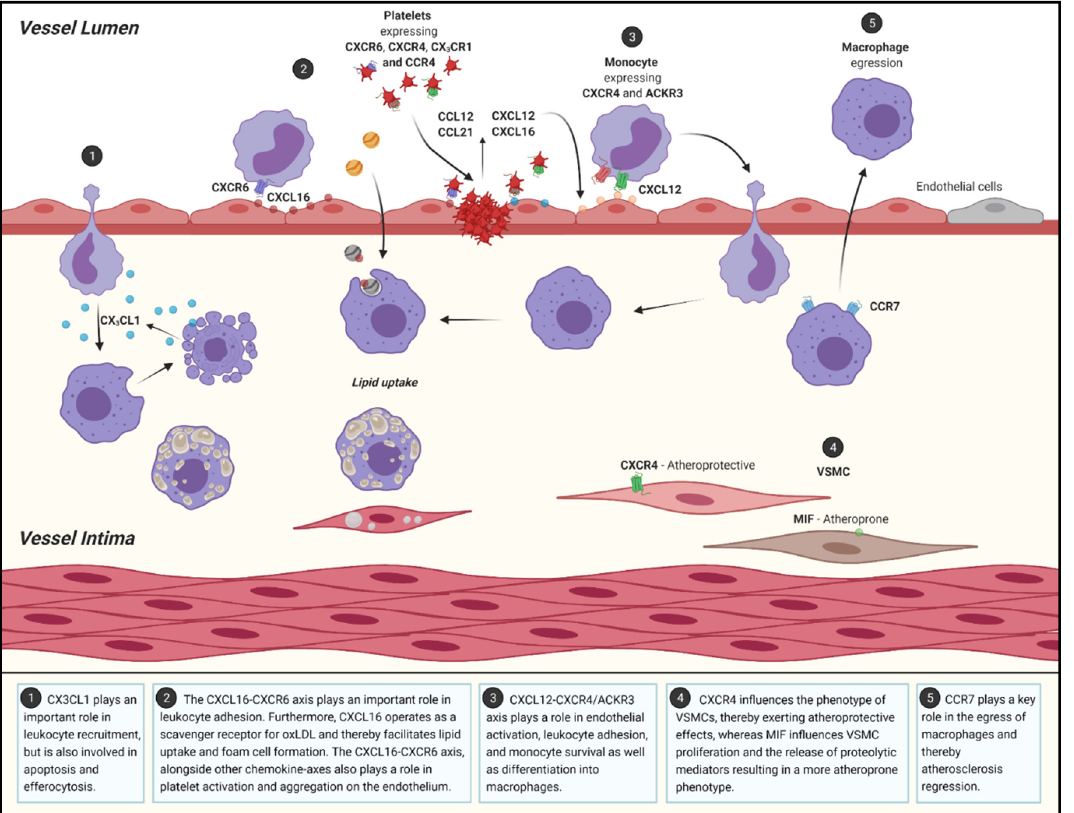
Figure 2. Schematic overview of the role of chemokines and chemokine-receptors in different processes during atherosclerosis progression and regression. VSMC: vascular smooth muscle cells . Figure was created using BioRender.com .